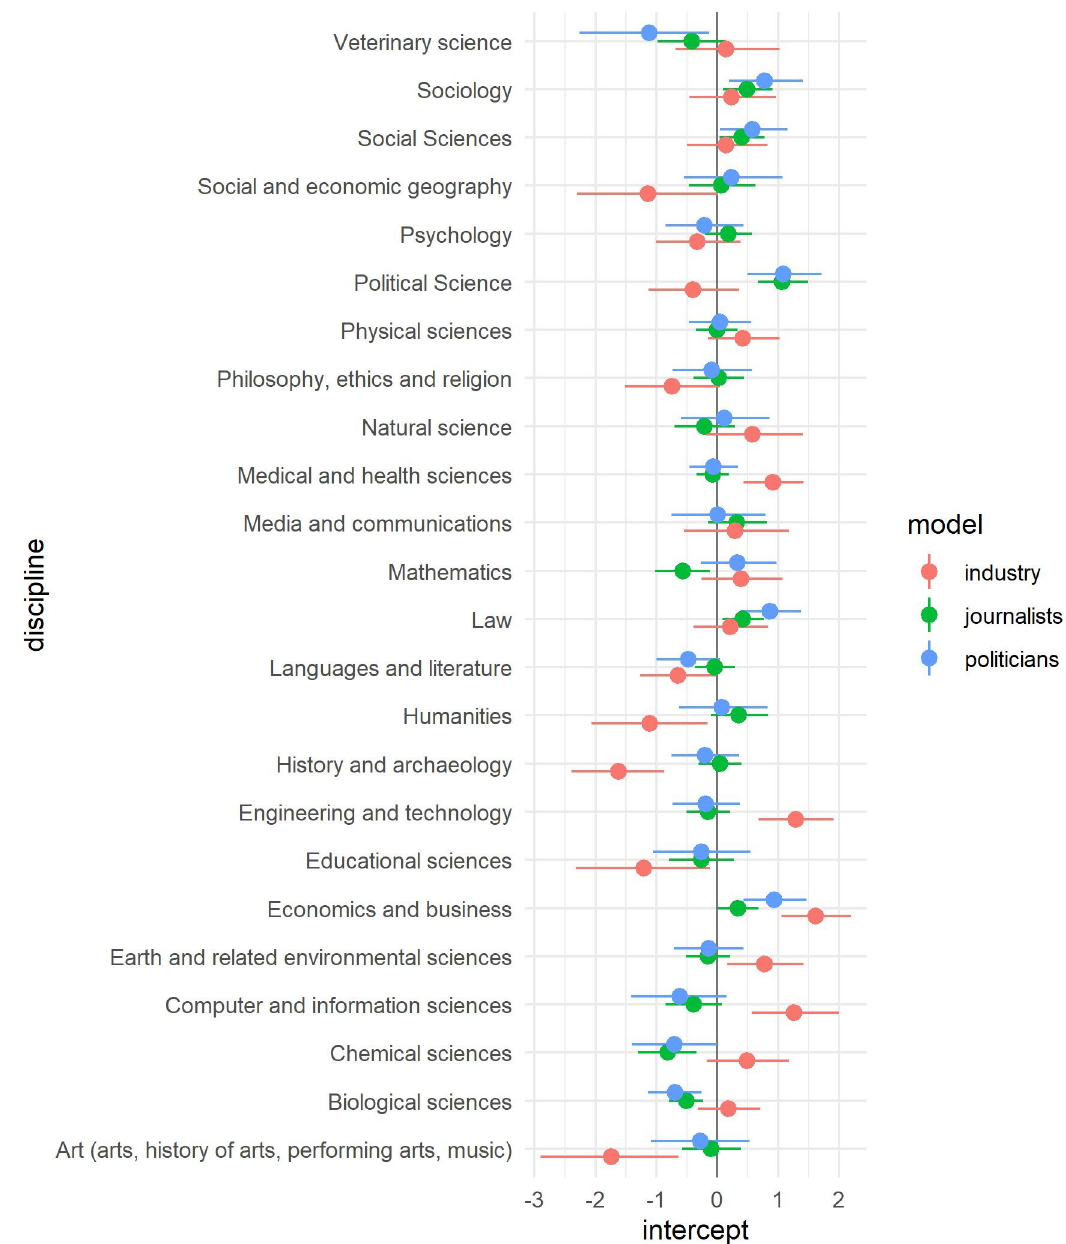
Fig 3. Varying intercepts for each discipline for all 3 models. Lines show the 95% CI of the